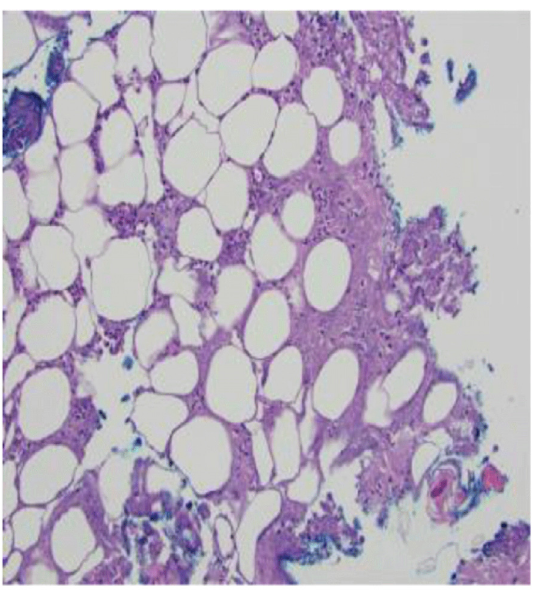
panniculitis with suppurative necrosis (20×, Hematoxylin and